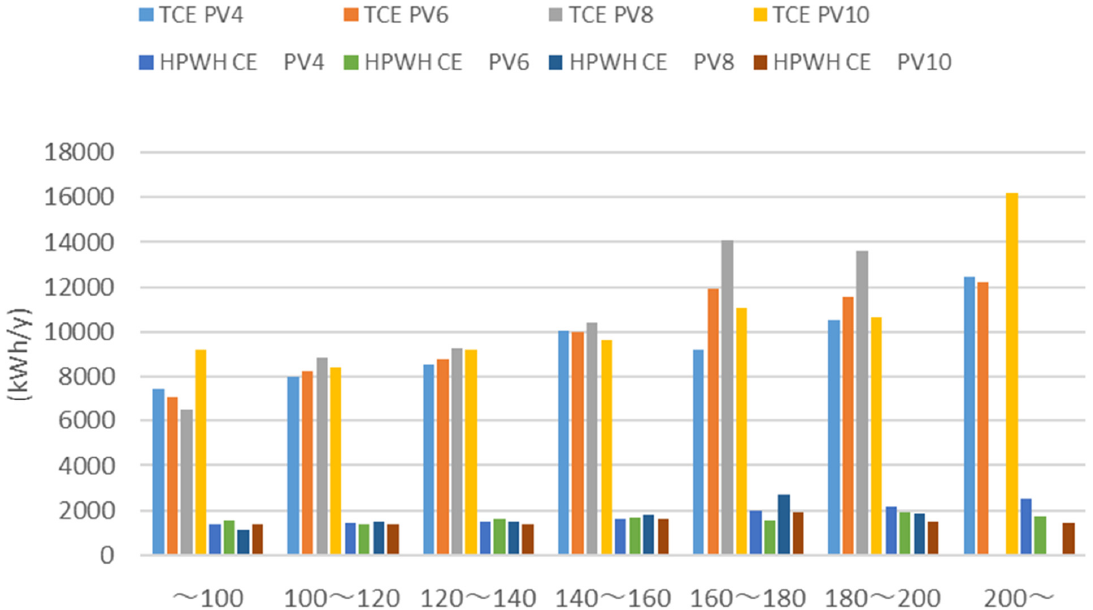
Figure 15. Annual power consumption and HPWH of floor space.